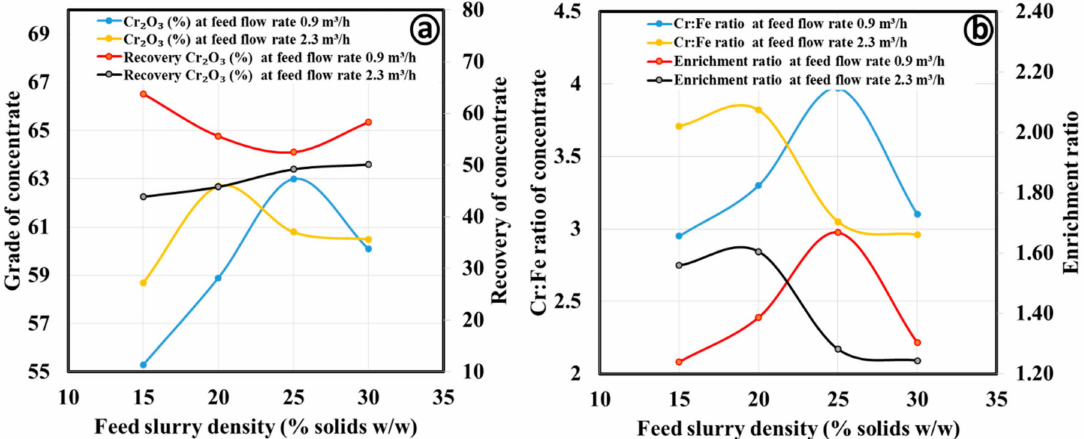
Figure 7. Influence of the feed flow rate and slurry density on the treatment of coarse concentrate by the spiral HG10i design ( a ) for grade and recovery; ( b ) for Cr:Fe ratio and enrichment ratio of